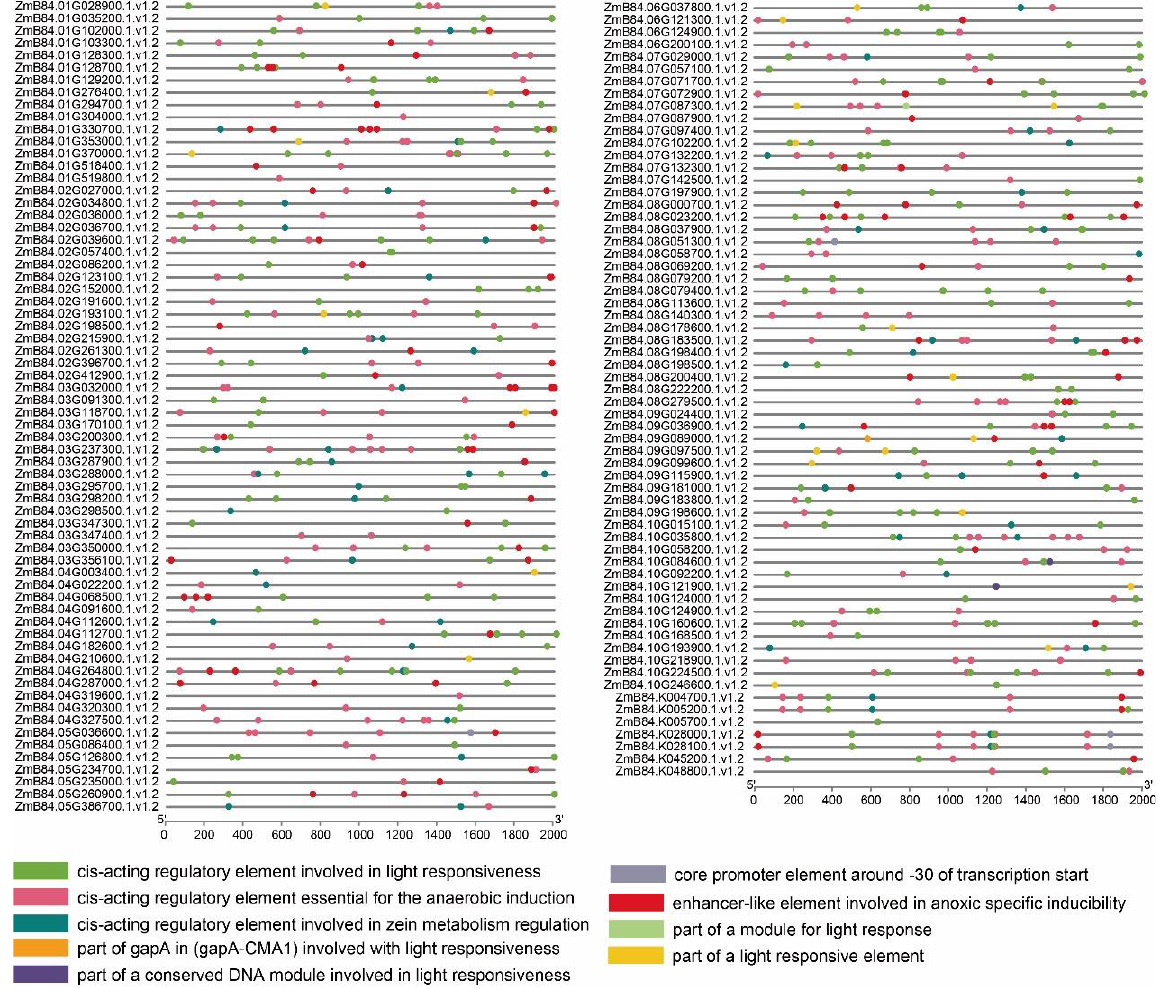
Figure 3. The cis-acting elements in the upstream promoter region of the maize ABC